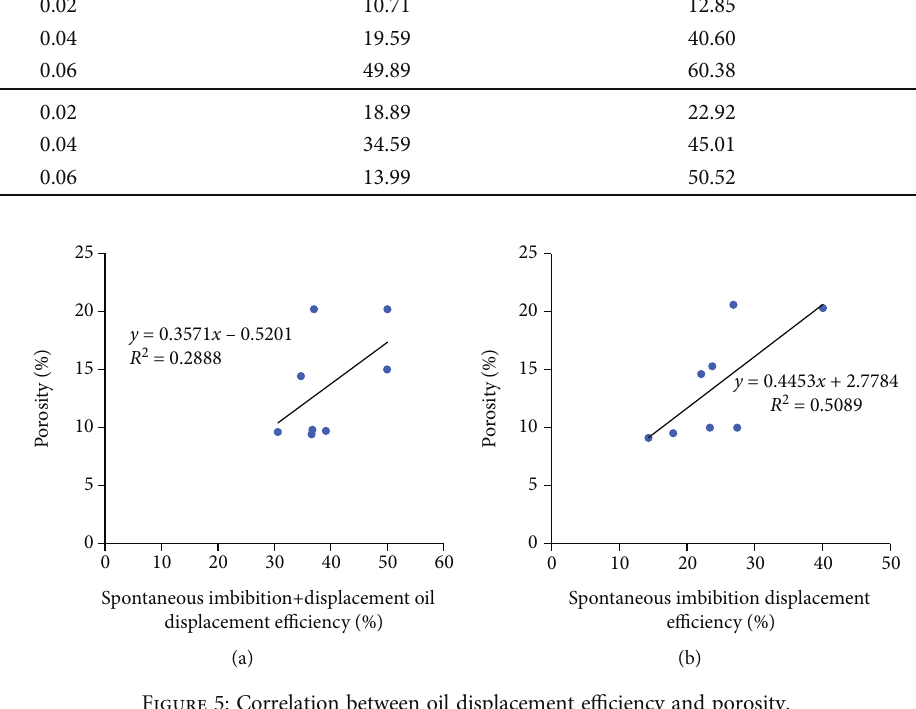
Figure 5: Correlation between oil displacement e ffi ciency and porosity.